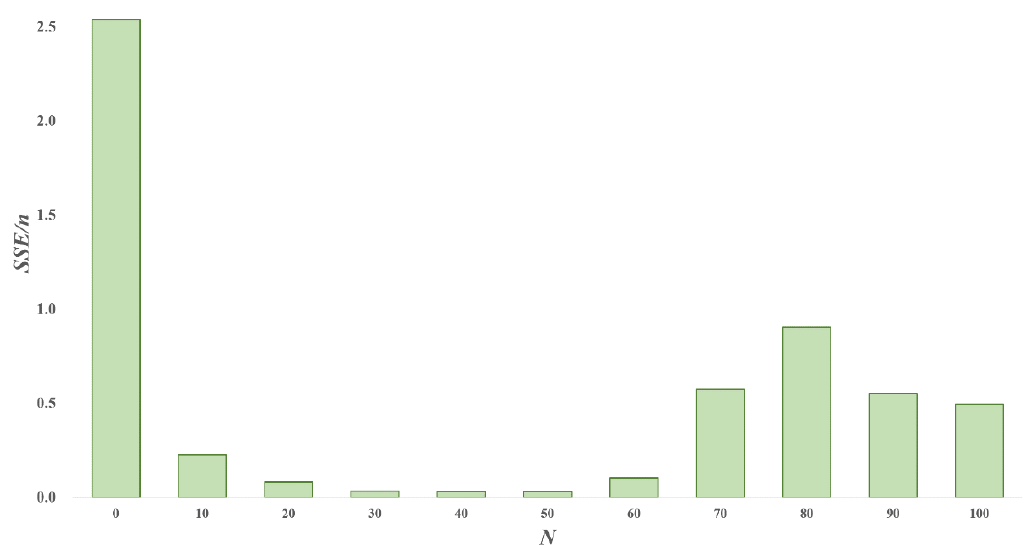
Figure 9. Spectrogram of 1 Hz vibration events applied on PZT with different averaging windows (spectrum range: 0~250 Hz).